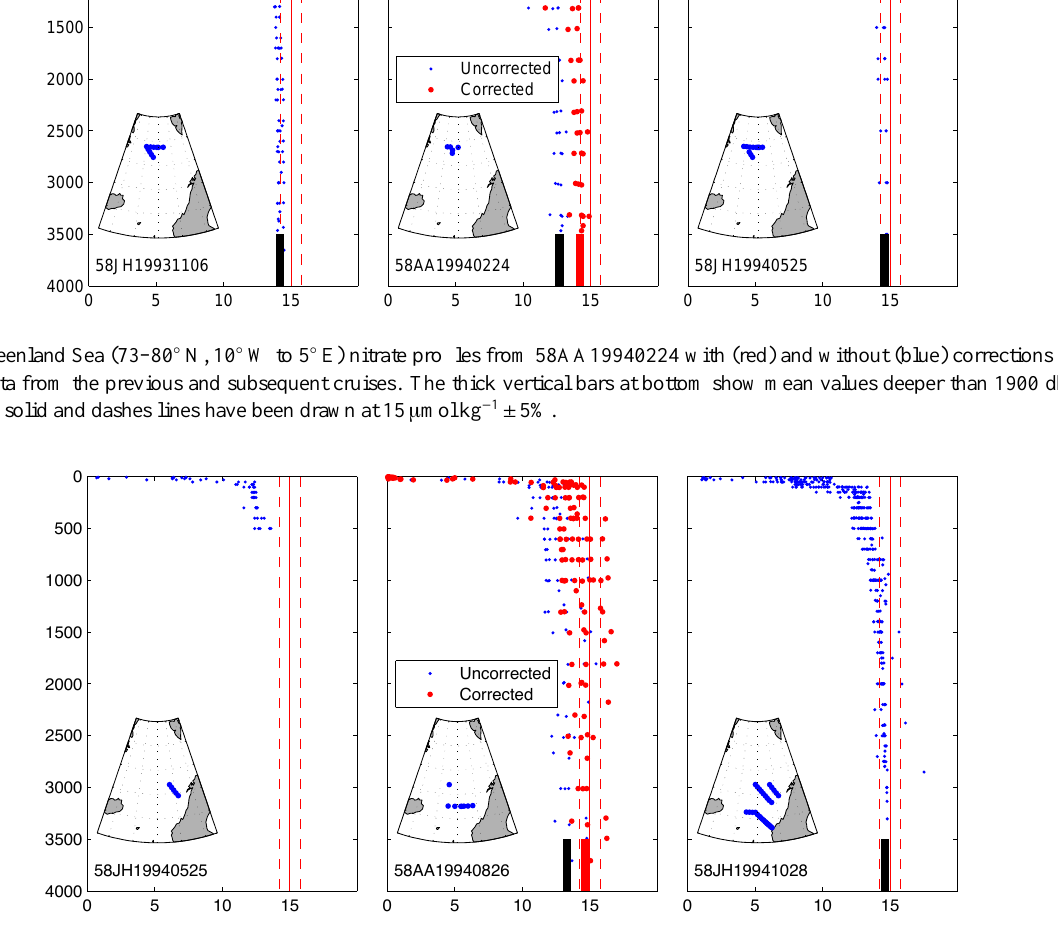
Figure 4. Norwegian Sea (61-70 ◦ N, 5 ◦ W to 10 ◦ E) nitrate profiles from 58AA19940826 with (red) and without (blue) corrections applied, along with data from the previous and subsequent cruises. The thick vertical bars at bottom show mean values deeper than 1900 dbar. For reference, red solid and dashes lines have been drawn at 15 µ molkg − 1 ±